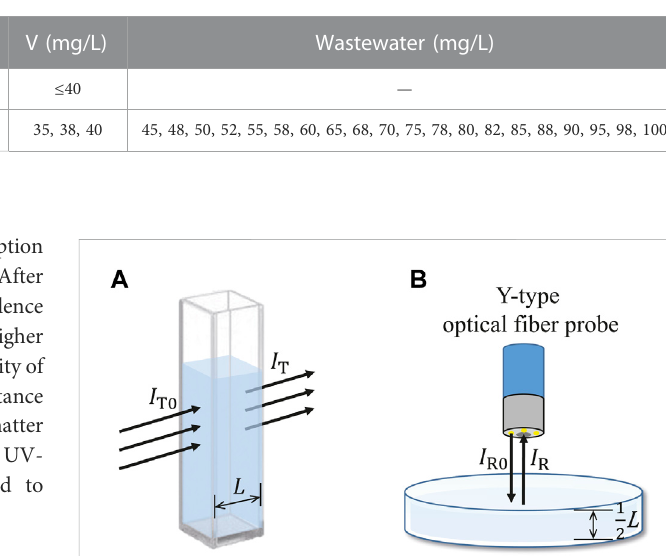
TABLE 1 The COD concentrations in standard water samples. COD CN is COD concentration of the Chinese national standard in surface water. COD EX is COD concentration of experimental water samples.